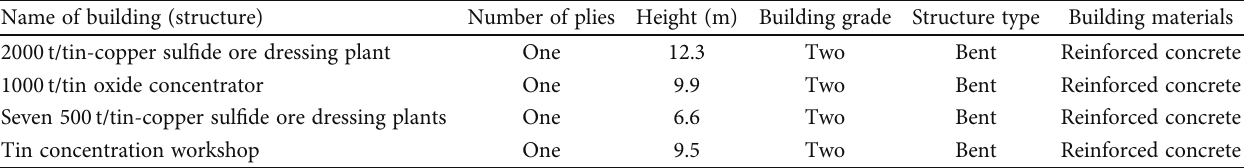
Table 7: List of proposed buildings.